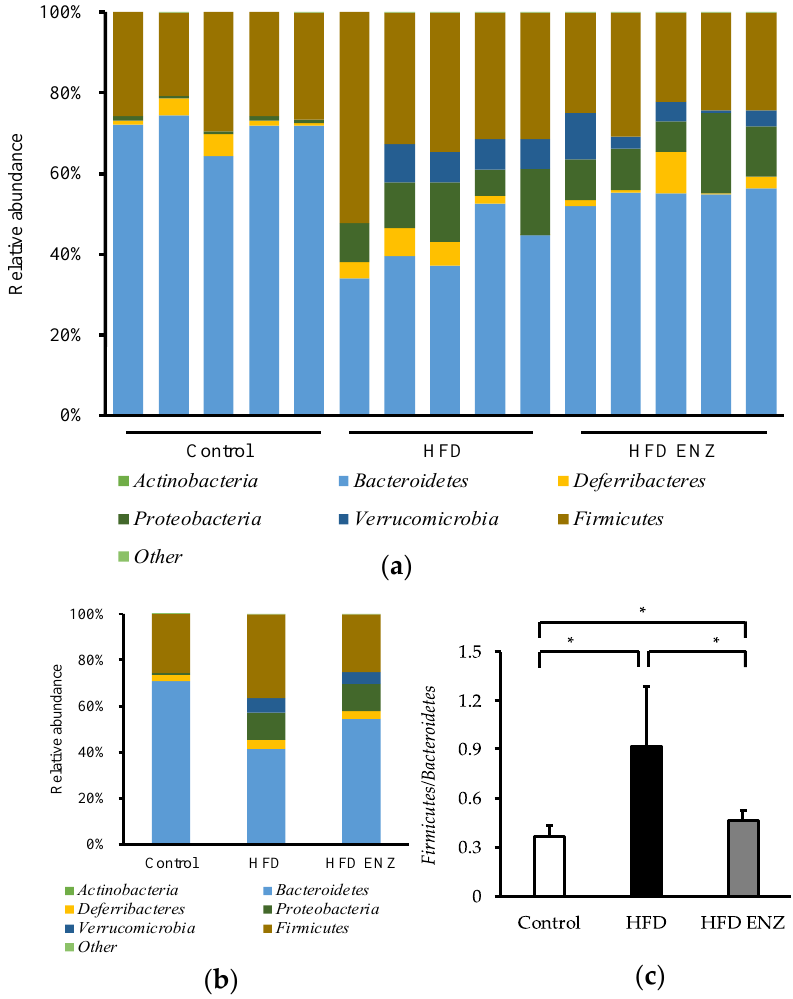
Figure 1. Composition of intestinal microbiota at phylum level. Each component of cumulative bar chart indicates a phylum level. ( a ) Individual composition, ( b ) comparative analysis of composition, and ( c ) Firmicutes -to- Bacteroidetes ratio. In ( c ), data are shown as mean ± SD, n = 5, * p <